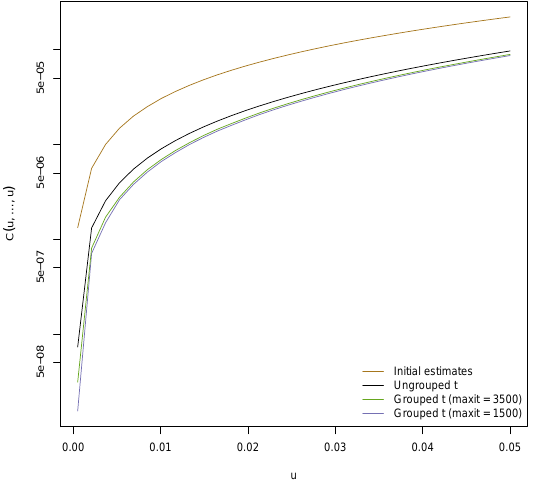
Figure 7. Estimated shortfall probability C ( u , . . . , u ) for grouped and ungrouped t copulas fitted to the standardized residuals obtained from the Dow Jones 30 dataset from 1 January 2014 to 31 December 2015 after